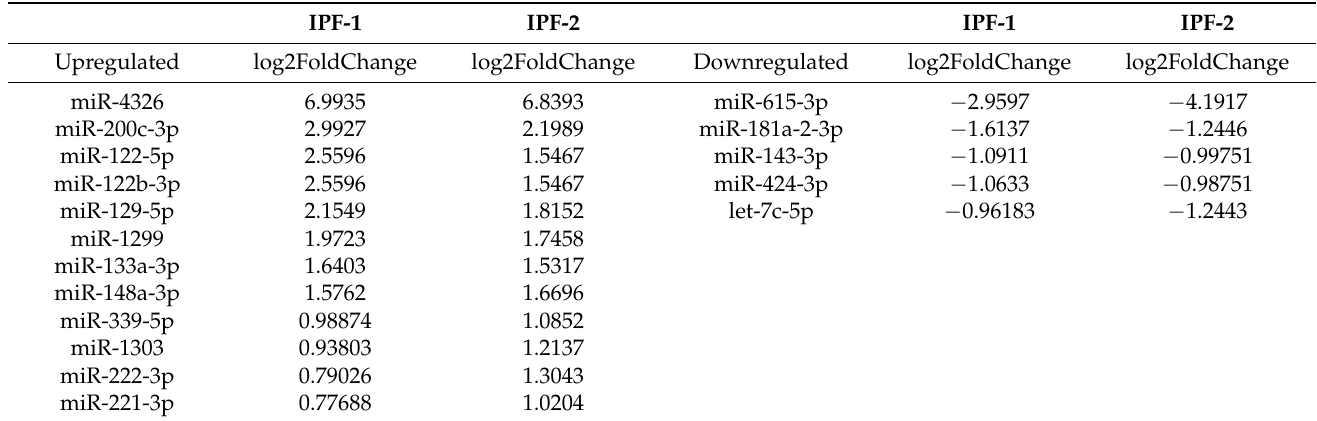
Table 1. Differentially expressed miRNAs of EVs isolated from IPF